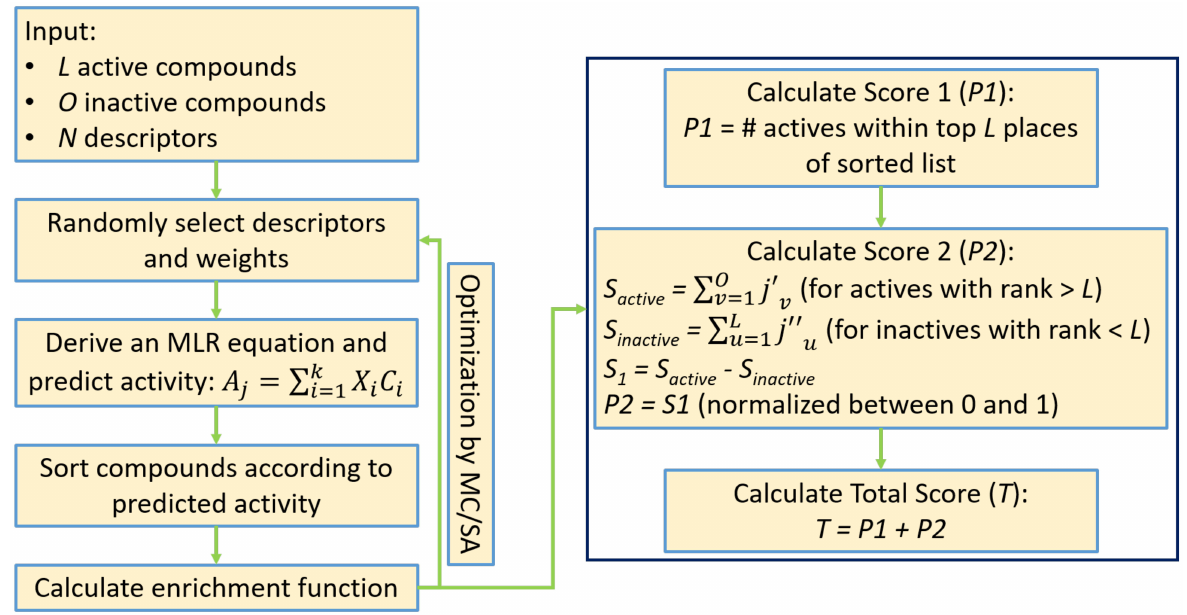
Figure 3. A flowchart of the modified enrichment optimizer algorithm (EOA). See the Supporting information for more